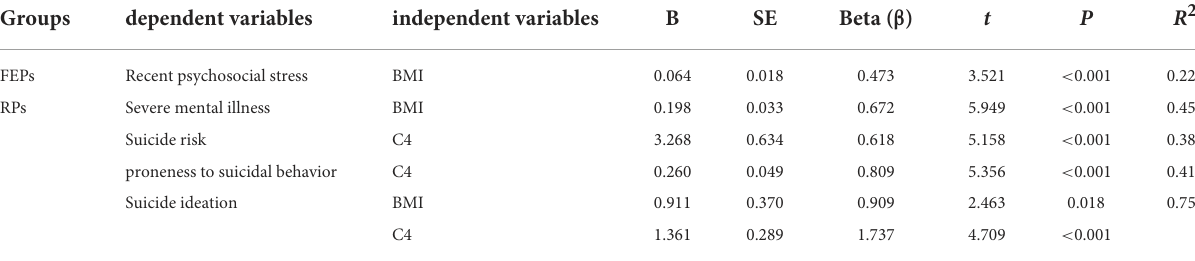
TABLE 6 Prediction of risk factors for the different dimension of suicide.